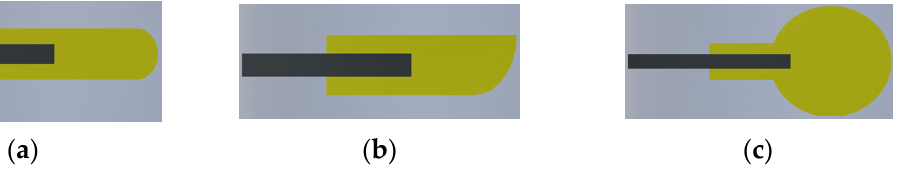
Figure 3. Key components with different radii of curvature. ( a ) key components with a radius of curvature of 5 mm, ( b ) key components with a radius of curvature of 12.5 mm, and ( c ) key components with a radius of curvature of 20 mm.